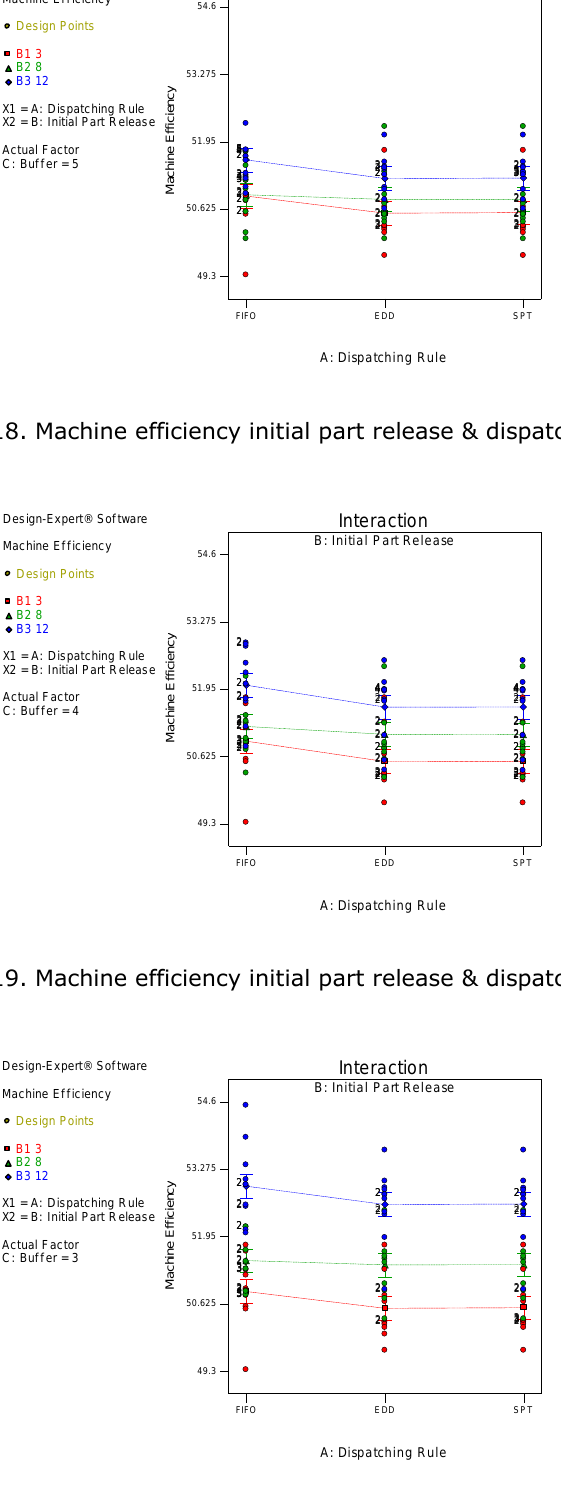
Figure 20. Machine efficiency initial part release & dispatching